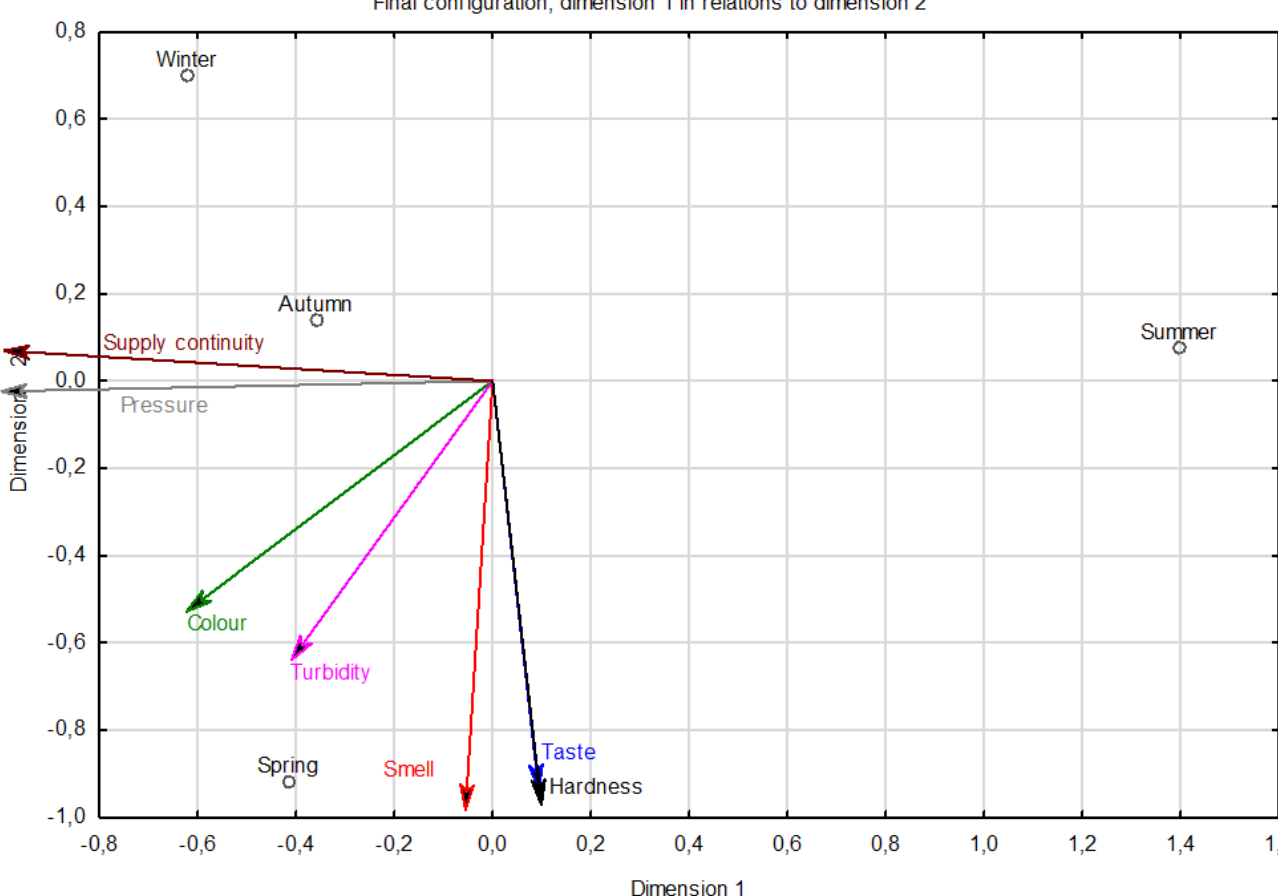
Figure 8. Biplot incorporating the result of multidimensional scaling based on individual tap water parameters.